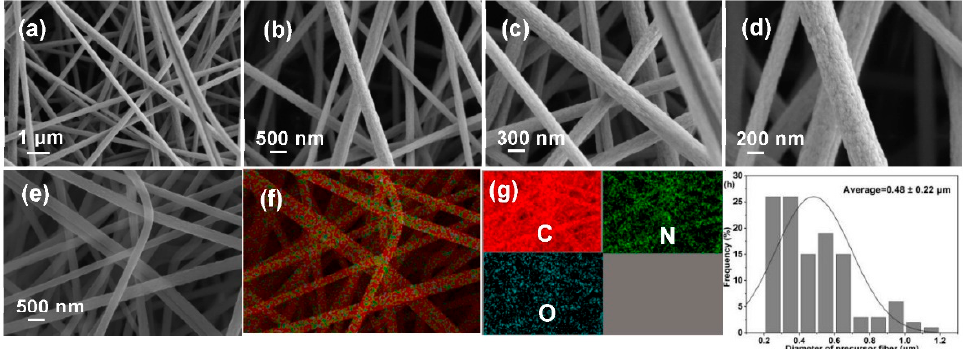
Figure 4. ( a – d ) SEM images, ( e – g ) EDX mapping, and ( h ) diameter distribution diagram of PFs.